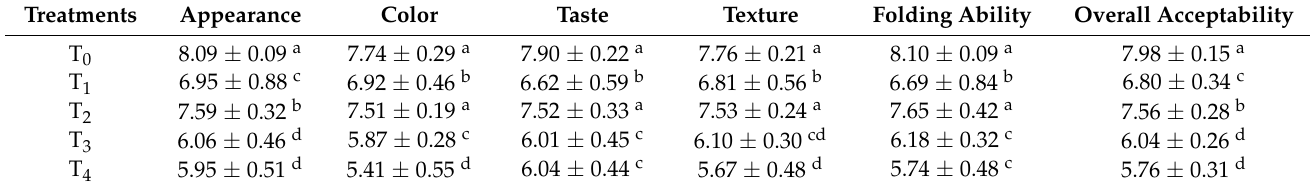
Table 6. Organoleptic properties of microwave-treated cabbage powder supplemented